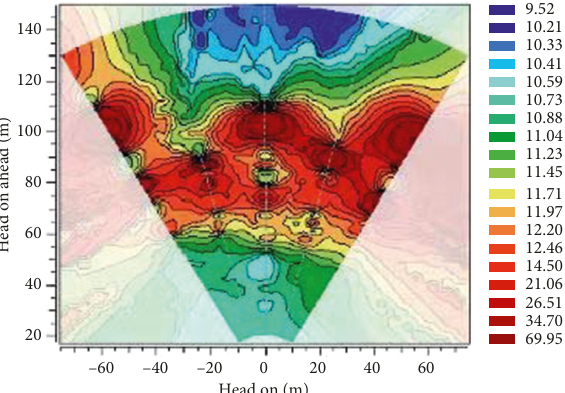
Figure 23: Apparent resistivity contour of rock pillar side after blasting at 800m of B3 track